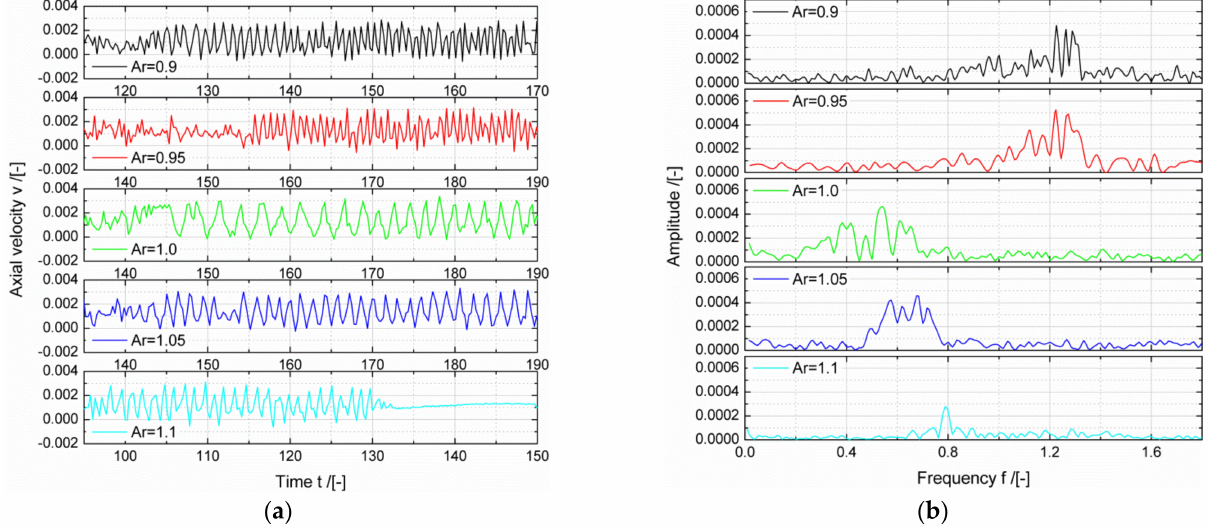
Figure 12. ( a ) Axial velocity oscillations at monitoring point i with different aspect ratios; ( b ) FFT spectra of axial velocity oscillations ( Ca C = − 0.01, R = 2.5 mm, H/R = 0.9, 0.95, 1.0, 1.05 and 1.1, Vr =